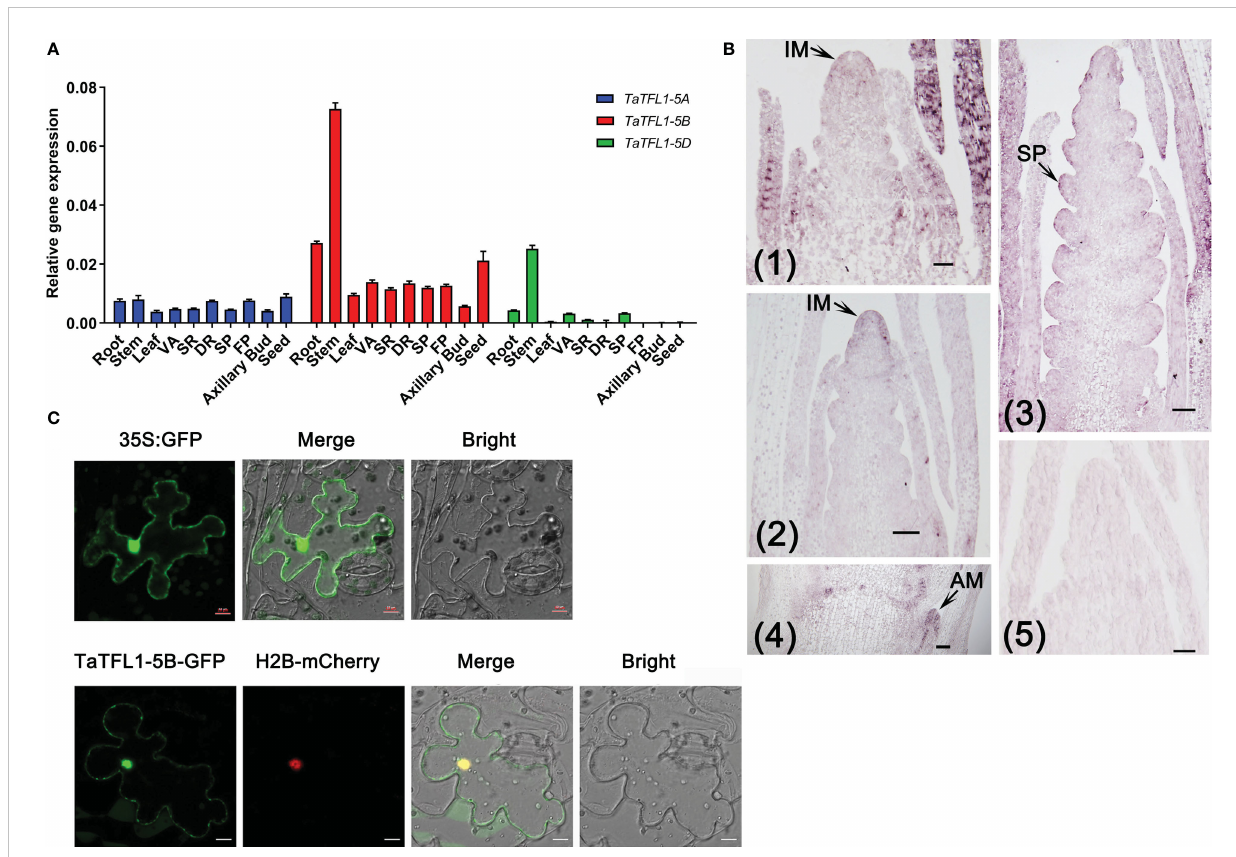
FIGURE 2 Expression patterns of TaTFL1 -5s and the localization of TaTFL1-5B. (A) qRT-PCR analysis of the relative expression levels of TaTFL1 -5s in different tissues of wheat development. DR, Shoot apex at the double ridge stage; FP, Shoot apex at the fl oret primordium stage; SP, Shoot apex at the spikelet primordium stage; SR, Shoot apex at the single ridge stage; VA, Vegetative apex; (B) RNA in situ hybridization analysis of the expression patterns of TaTFL1 -5s at the early stage of spike development. (1) Longitudinal section of the shoot apex at the single ridge stage; (2) Longitudinal section of the shoot apex at the double ridge stage; (3) Longitudinal section of the young spike; (4) Longitudinal section of the young stem showing the axillary meristem; (5) Sense probe control. AM, axillary meristem; IM, In fl orescence meristem; SP: spike primordium. Bars, 100 µm. (C) Co- localization of TaTFL1-5B with H2B visualized using transient expression of 35S:: TaTFL1-5B-GFP and 35S:: H2B-mCherry in tobacco leaves. The co- localization signal was tested at 50 h after infection. The expression of 35S: GFP was used as the control. Bars, 10